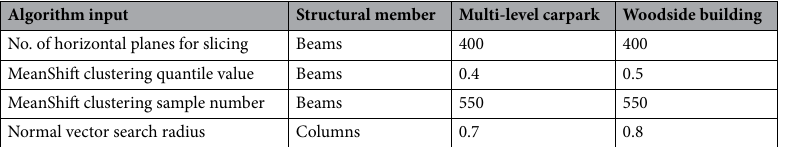
Table 1. Inputs and thresholds used for finding position information from point